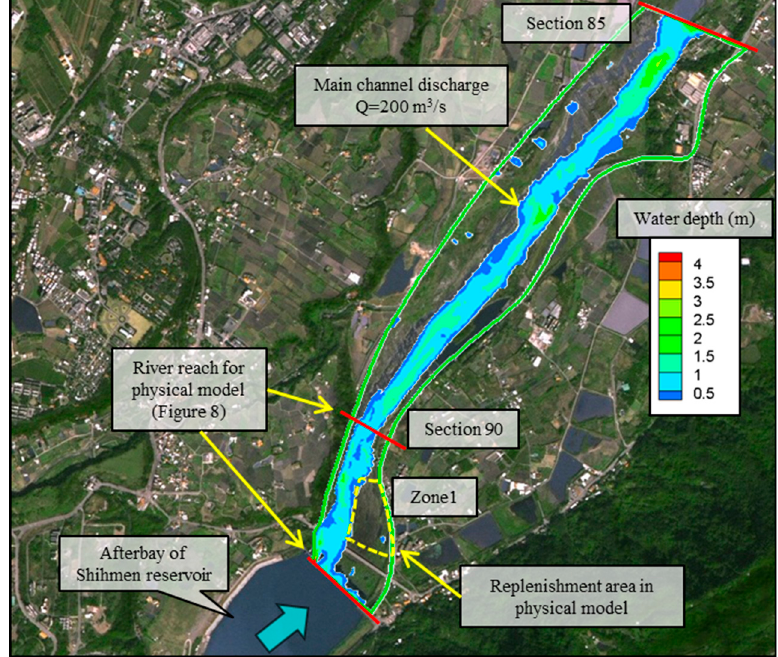
Figure 6. Downstream river reach for evaluation with a discharge of 200 m 3 /s.